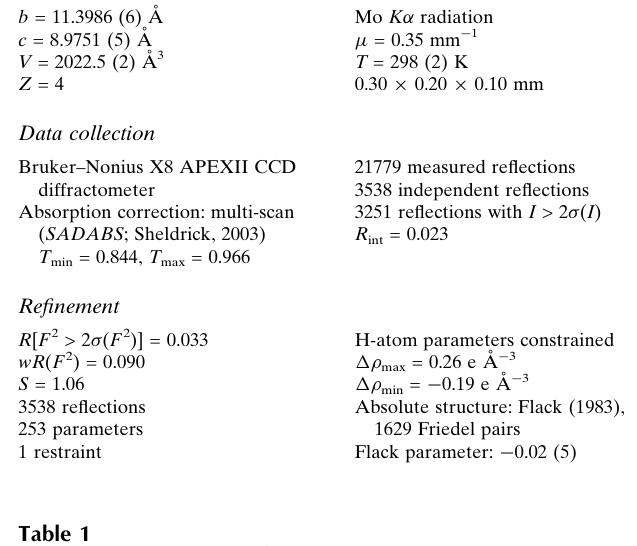
Hydrogen-bond geometry (A˚ , (cid:3)